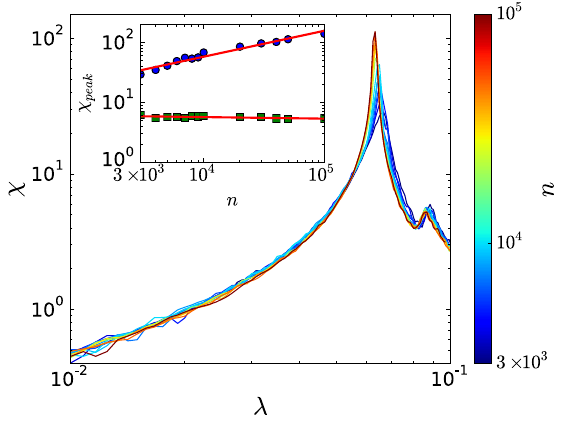
FIG. 14. Finite-size analysis of the susceptibility. In the main panel, we have the susceptibility as a function of λ for different sizes of two-layer multiplex networks, where the first layer has h k i ¼ 16 and the second h k i ¼ 12 . In this experiment, we fixed the ratio ð η = λ Þ ¼ 0 . 01 . In the inset, we show the susceptibility of the two peaks as a function of the layer size, where the blue symbols refer to the first peaks while the green symbols refer to the second peak. In addition, the red lines are a linear fitting of those points. The layer sizes evaluated are n ¼ 3 × 10 3 , 4 × 10 3 , 5 × 10 3 , 6 × 10 3 , 7 × 10 3 , 8 × 10 3 , 9 × 10 3 , 10 4 , 2 × 10 4 , 3 × 10 4 , 4 × 10 4 , 5 × 10 4 , 10 5